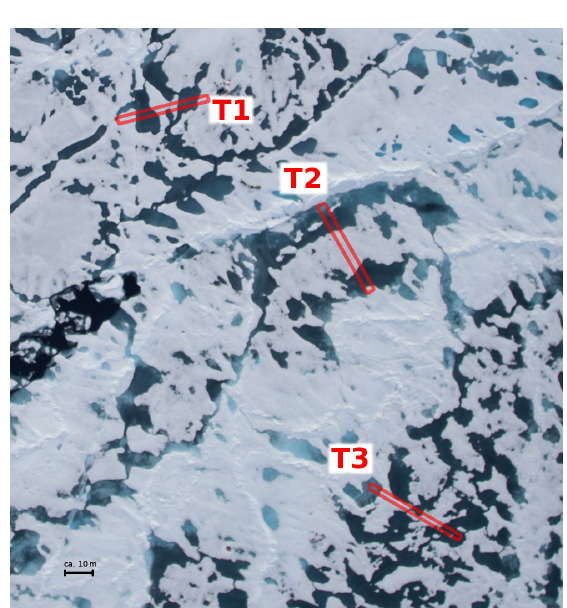
Figure 1. Aerial photo of part of the study area taken from a heli- copter on 28 July 2012, with the three transects marked. The labels are placed at the start of each transect. The lengths of the transects 1, 2, and 3 were approximately 33, 35, and 38m, respectively. The whole image covers approximately 180m ×